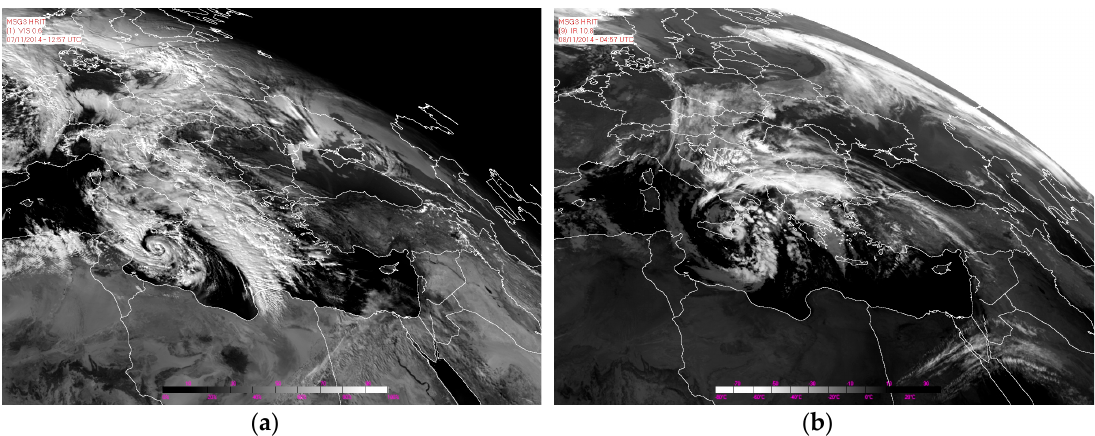
Figure 2. EUMETSAT Meteosat Second Generation-3 satellite images of ( a ) the visible channel (0.6 µ m) on November 7th 2014, 12:57 UTC and ( b ) the infrared channel (10.8 µ m) on November 8th 2014, 04:57 UTC.